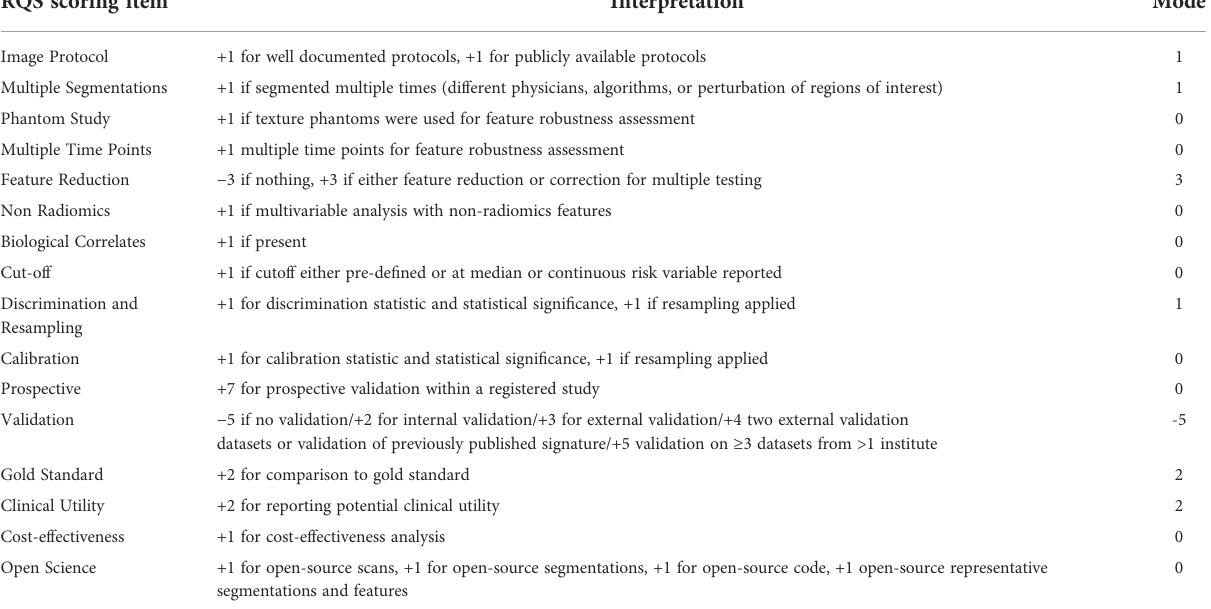
TABLE 3 Elements of the RQS and average rating achieved by the studies included in this systematic review.